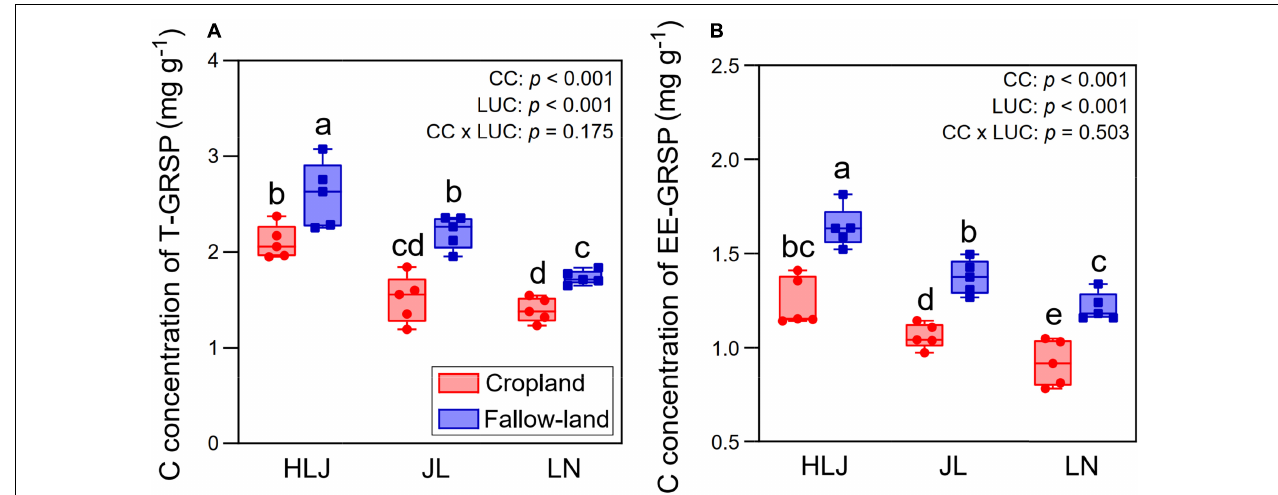
FIGURE 6 | Effects of CC and LUC on C concentrations of T-GRSP (A) and EE-GRSP (B) . Means ± SD ( n = 5) followed by different letters at the bar indicate significant differences ( p < 0.05) among treatments.